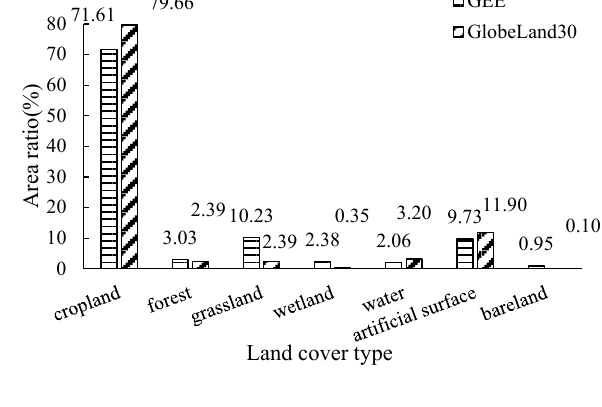
Figure 4. Area ratio of land cover